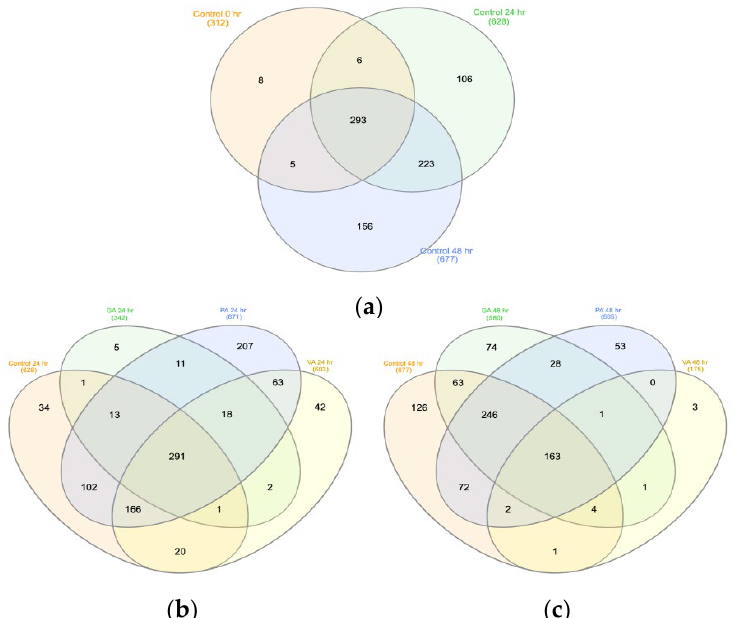
Figure 7. Multivariate Venn diagram demonstrating species commonness between sample OTUs by comparing controls at different timepoints ( a ) as well as the control, gallic acid (GA), protocatechuic acid (PA), and vanillic acid (VA) treatment groups at the 24 h timepoint ( b ) and control, GA, PA, and VA treatment groups at the 48 h timepoint ( c ).